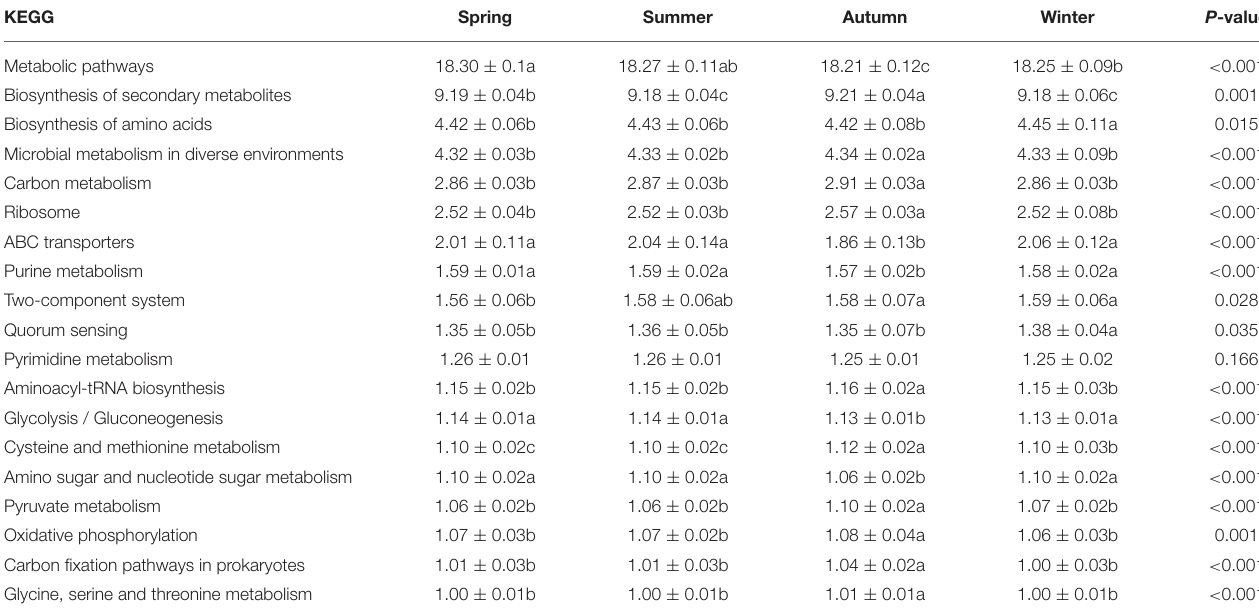
TABLE 2 | PICRUSt shows the predicted relative abundance of all KEGG signaling pathways in fecal microbes (Level 3 Kos, > 1%).